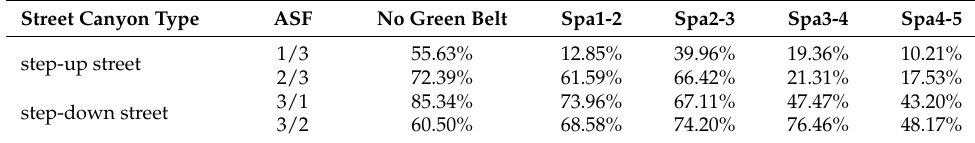
Table 2. Area/percentage of ideal flow velocity under different street canyon